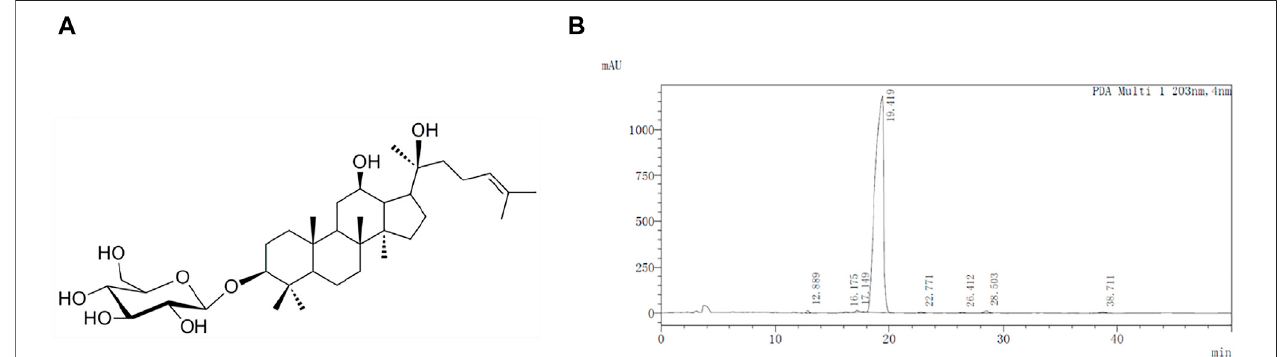
FIGURE 1 | Molecular structure (A) and HPLC pro fi le (B) of